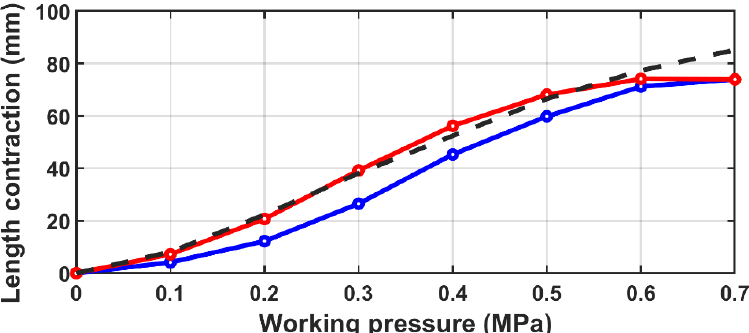
Figure 13. Diagram of correlation between the length contraction and working pressure for m = 2.5 kg: dashed line for theoretical modeling, blue line for experimental results of lifting a load, red line for experimental results of lowering a load.